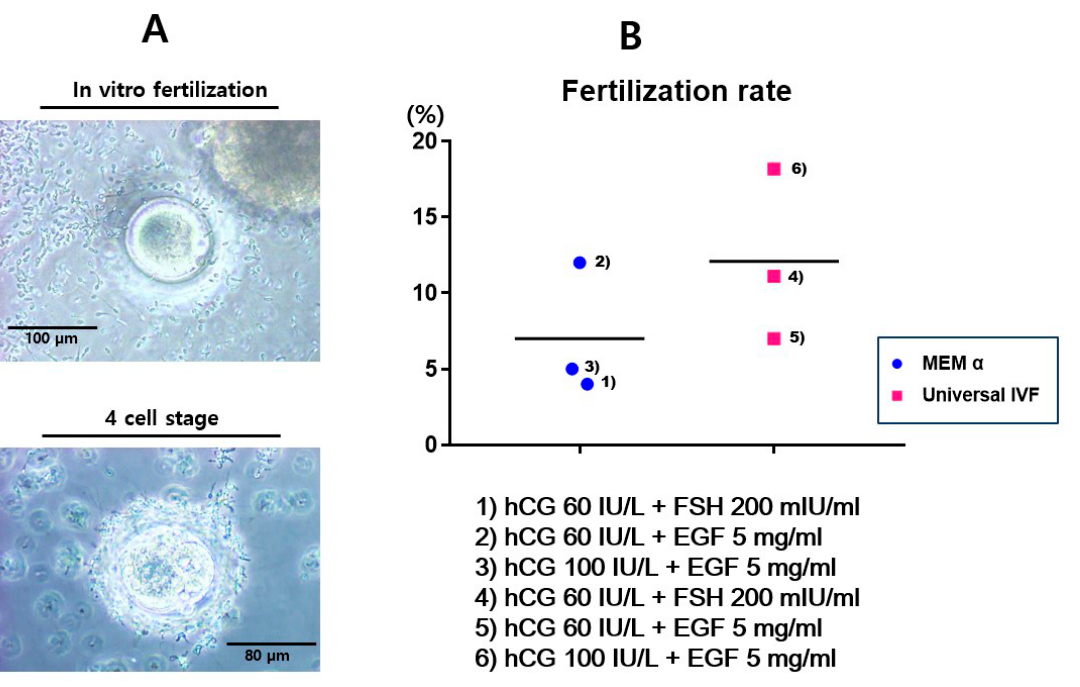
Figure 3. In vitro fertilization of marmoset oocytes using different conditions. ( A ) Fertilization and development into the four-cell-stage. In vitro fertilization (IVF) was achieved using viable sperm, and fertilization was confirmed by observation of 2-pronuclei (2PN). In vitro development into the further stage was confirmed after 48 h. ( B ) Fertilization rate using each condition of hormone combinations. The rates were calculated based on the appearance of 2PN after IVF.